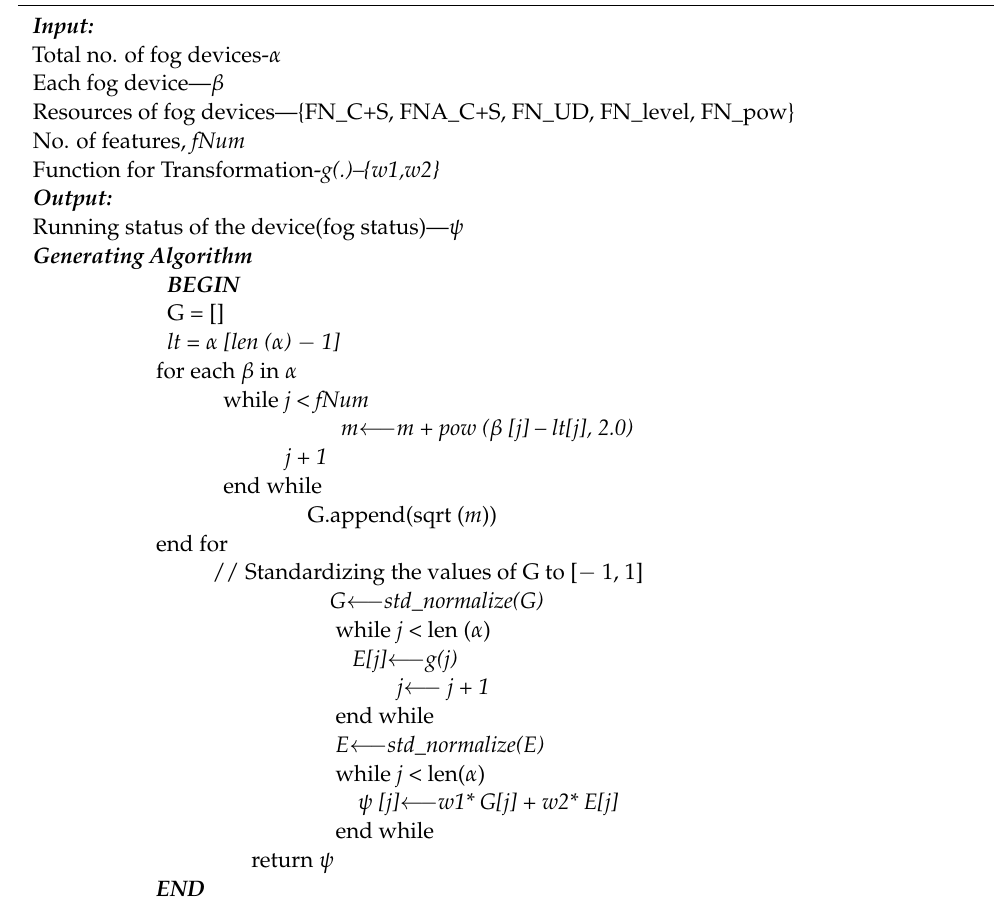
Algorithm 2: LSTM Fault